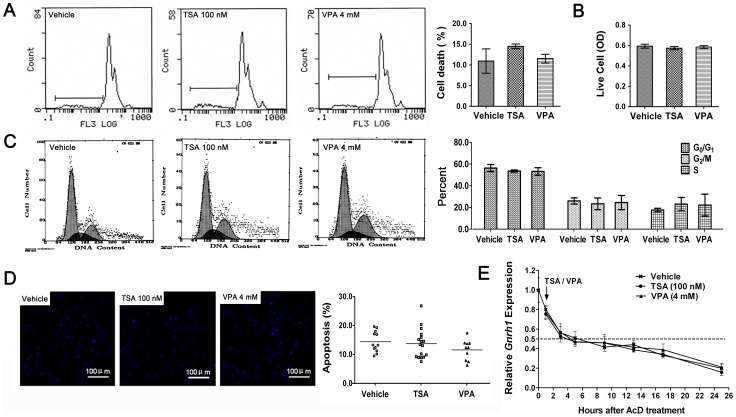
HDACIs-induced inhibiton of Gnrh1 gene transcription.(A–D) Effects of HDACIs on cytotoxicity, cell cycle progression and apoptosis. (A) Cytotoxicities of HDACIs were detected by flow cytometric (n = 3) and (B) the survival rates of the cells were detected by MTT assay (n = 10). (C) The effects of HDACIs on cell cycle progression were analyzed by PI flow cytometry assays (n = 3). There is no difference among the groups (One-way ANOVA). (D) The apoptosis of the GT1–7 cells treated with HDACIs for 24 h was detected by Hoechst 33258 fluorescent staining. The number of cells present in each image was 50–100. The percentage of apoptotic cells was calculated by dividing the numbers of cells with bright and small nuclei with the total numbers of cells in the image. There is no difference among the groups (n>10, One-way ANOVA). (E) HDACIs inhibited Gnrh1 gene transcription rather than decreased the stability of Gnrh1 mRNA. GT1–7 cells were pretreated with 0.01 µM AcD for 1 hour prior to the addition of HDACIs. The arrow represents the point of time for adding HDACIs. The mRNA level was examined by real-time RT-PCR. The value for sample treated by AcD at 0 h was used as control and set as 1.0. (n = 3).